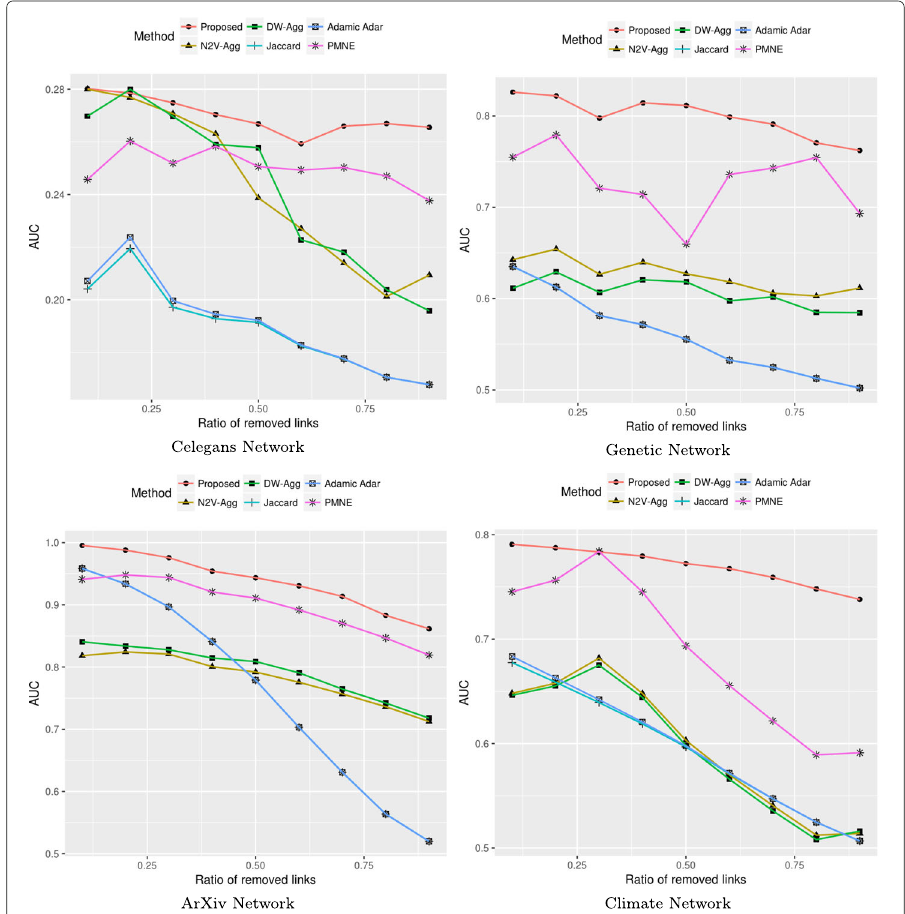
Fig. 3 Performance of the proposed model on different real-world